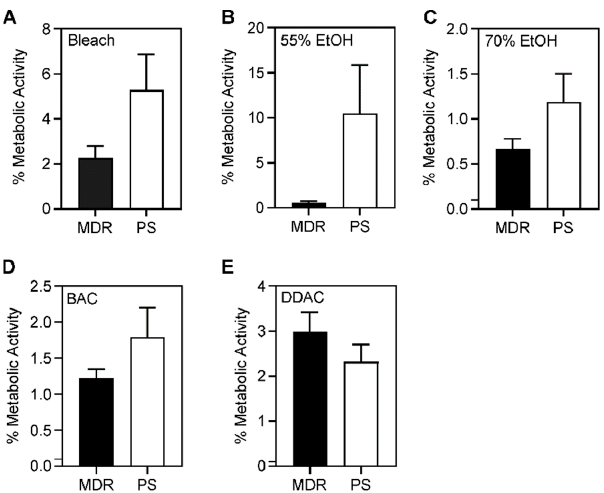
Figure 6. Comparison of survival of bacterial biofilms formed by multidrug-resistant and pan-susceptible strains. Average percentage of metabolic activity of five MDR versus five PS biofilms after ( A ) 4 min of bleach, ( B ) 1 min of 55% ethanol, ( C ) 1 min of 70% ethanol, ( D ) 2 min of 0.5% BAC, and ( E ) 1 min of 0.61% DDAC exposure. The average metabolic activity is displayed; error bars represent standard deviations. A p -value of ≤ 0.05 was considered significant. No significant differences were